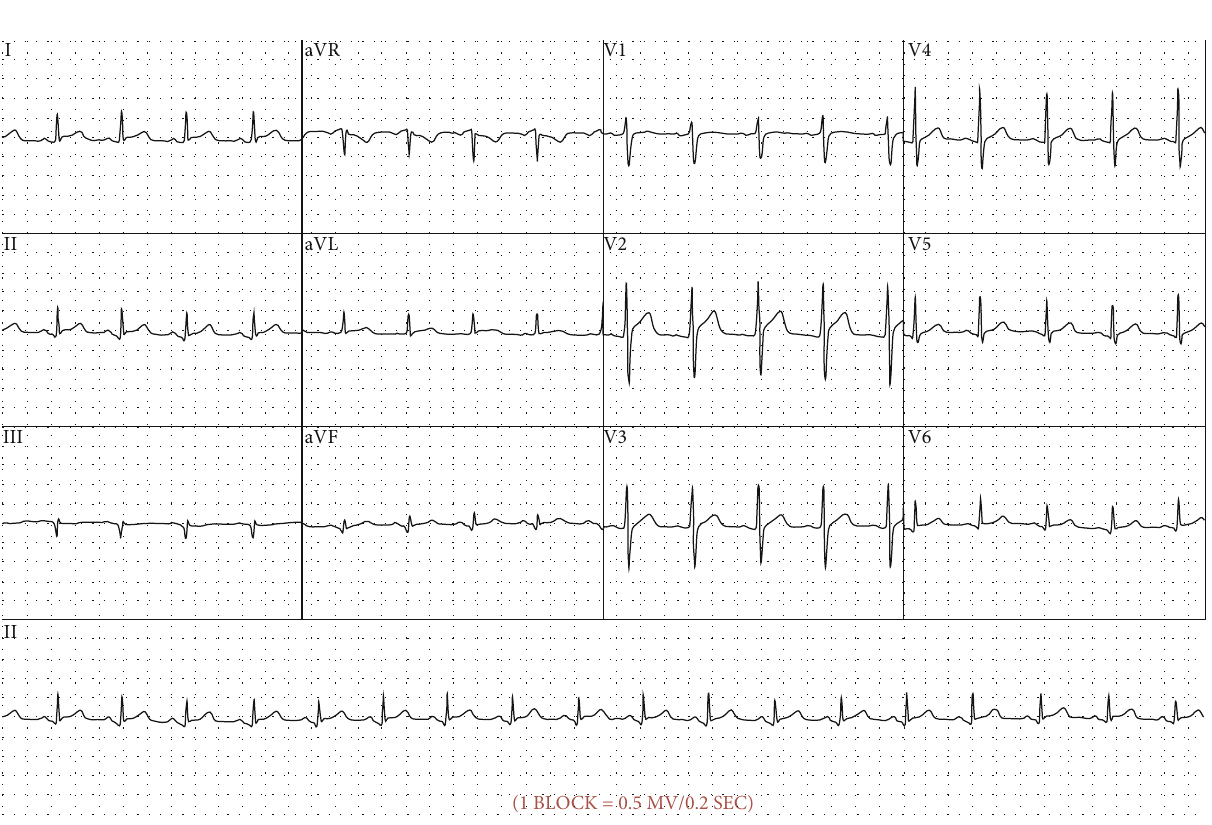
Figure 3: Electrocardiogram of the patient. Electrocardiograph (ECG) recorded during the patient ’ s initial presentation. PR segment depression and ST segment elevation in leads I, II, aVF, aVL, and V2-V6 and demonstrated.